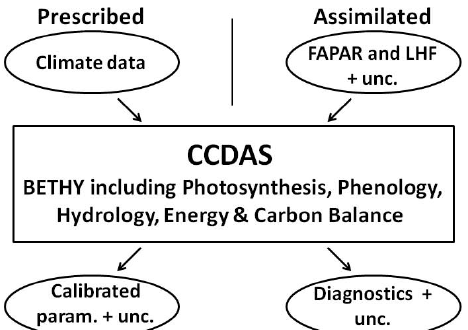
Fig. 1. Schematic diagram of the CCDAS structure. Ovals represent input and output data, and boxes represent calculation steps. Diag- nostics are quantities of interest such as carbon fluxes computed by CCDAS. “unc.” stands for uncertainty and “param.” for